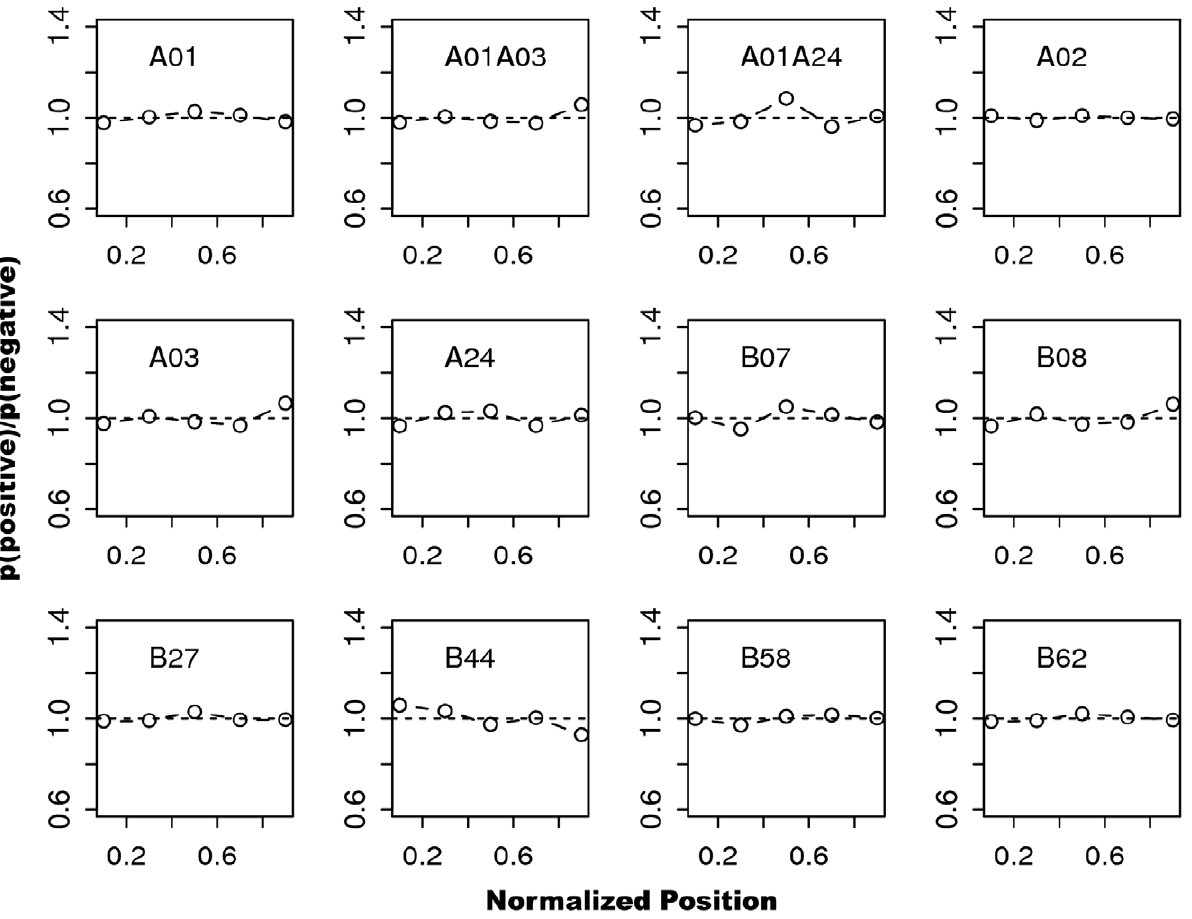
Figure 2. Positional biases of predicted binders for 12 HLA supertypes. For each supertype, 9-mer peptide binding predictions were carried out and ratios of probability masses of predicted ‘binders’ and ‘non-binders’ were calculated. Peptide binding predictions were made for alleles belonging to each supertype, using SMM PMBEC method. All possible 9-mer peptides were generated from a set of viral proteins that contain at least one tested peptide from Table 1. Relationships between HLA molecules and supertypes are provided in